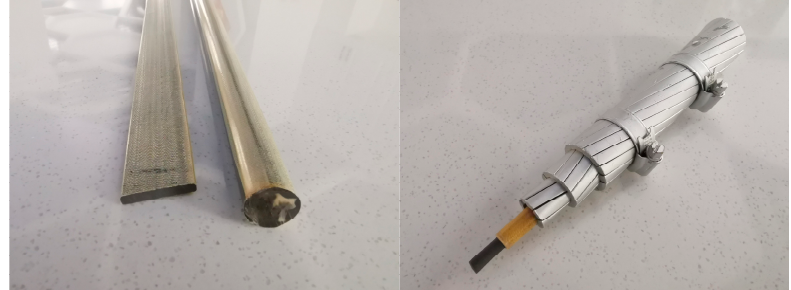
Figure 1. Carbon fibre sucker rod and conductor core.